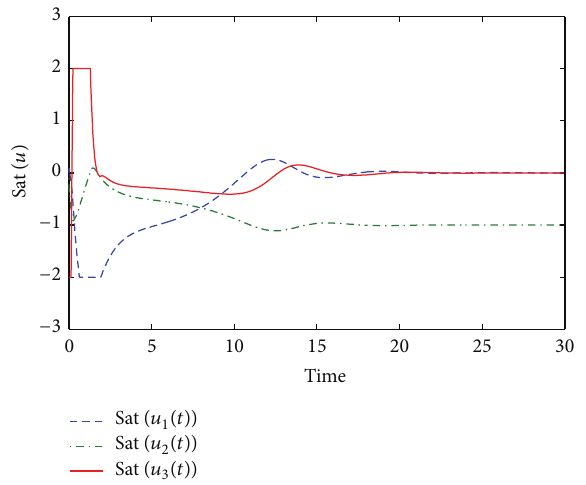
Figure 7: Time response of the control inputs with fractional order 𝛼 = 1.04